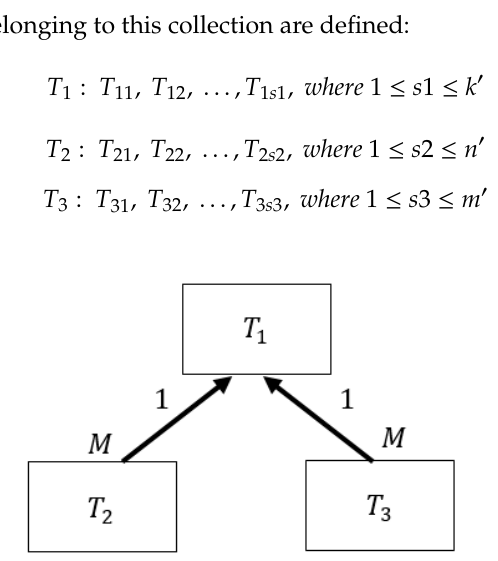
Figure 2. The scheme of relationships between tables T 1 , T 2 , and T 3 for the case when the first table